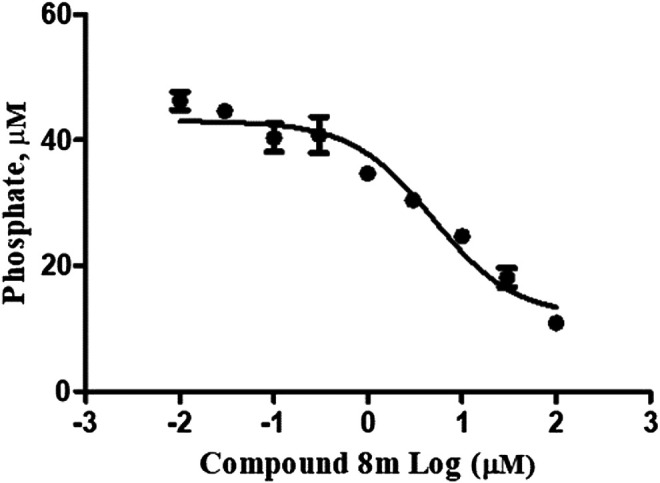
Compound 8m inhibits the ectonucleotidase activity in islet homogenate, measured as release of Pi from exogenously added ATP at a concentration of 100 µM (n = 3).